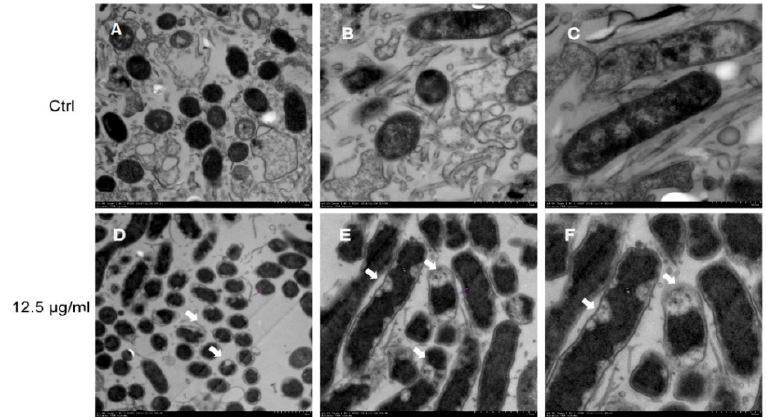
Figure 2. The morphology of H. pylori cells with/without daphnetin exposure observed by SEM. Control ( A , D ); H. pylori were treated with 6.25 μ g/mL ( B , E ) or 12.5 μ g/mL of daphnetin ( C , F ). Magnification: A–C = 4000; D–F = 40000.